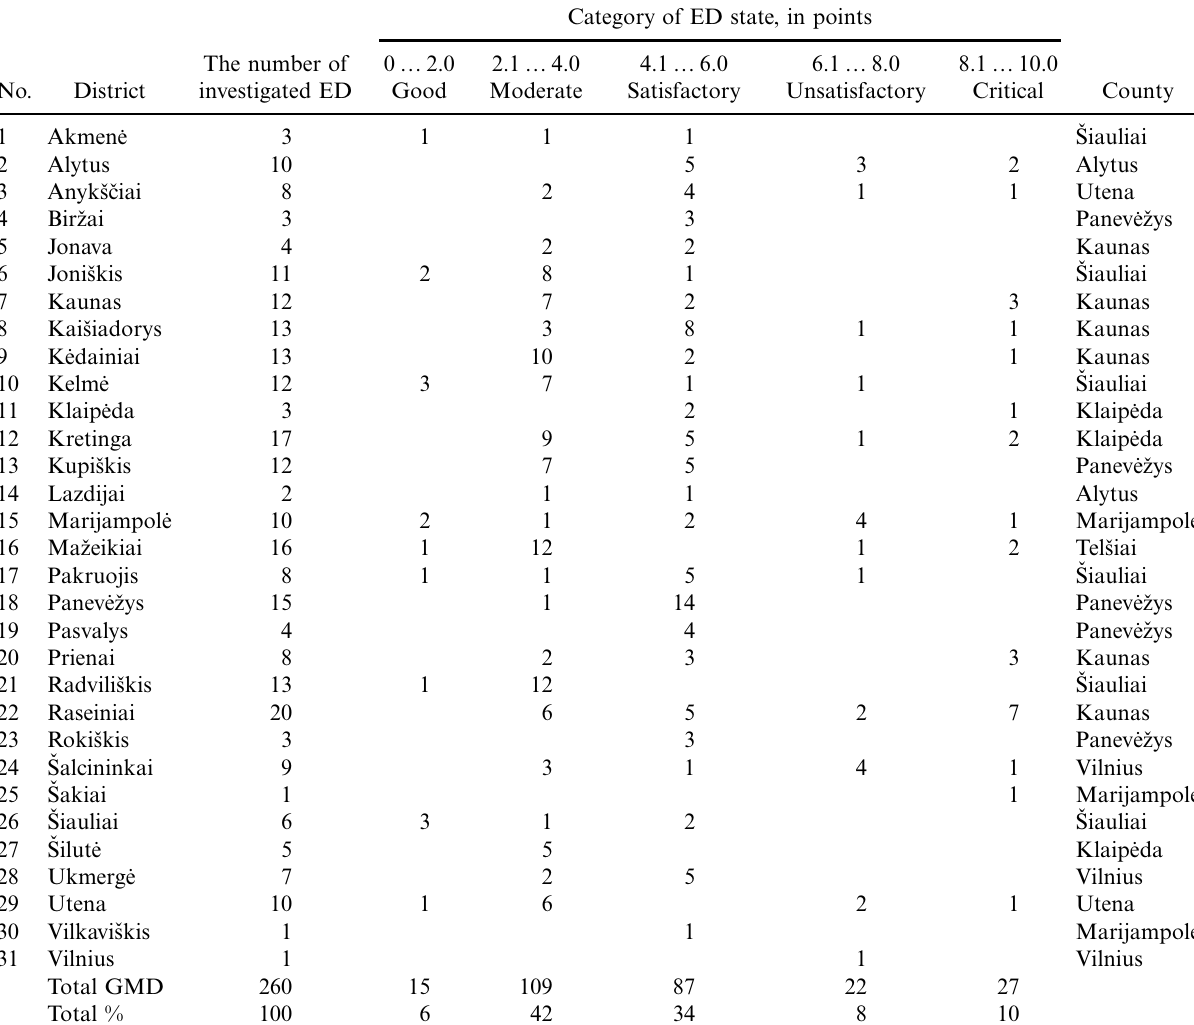
Table 1. Evaluation of technical state of investigated earth dams in